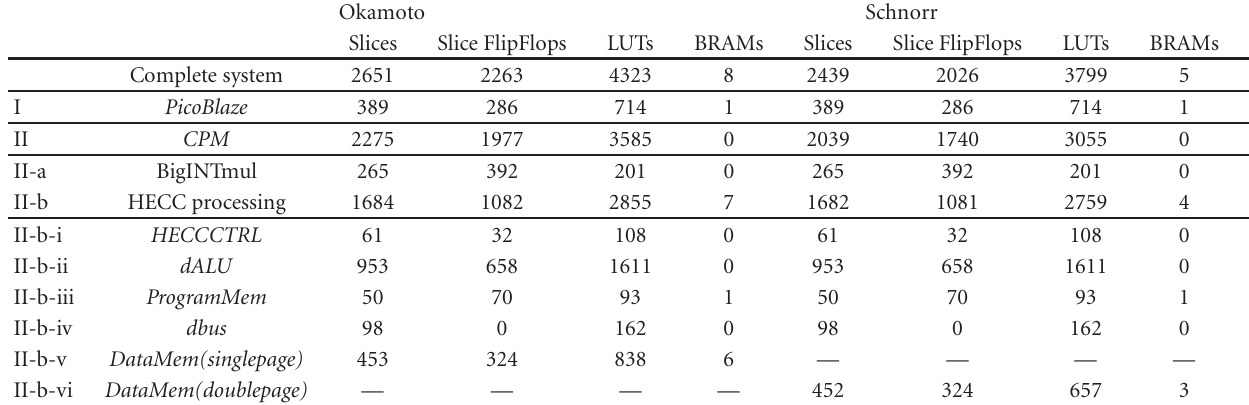
Table 1: Resource usage.